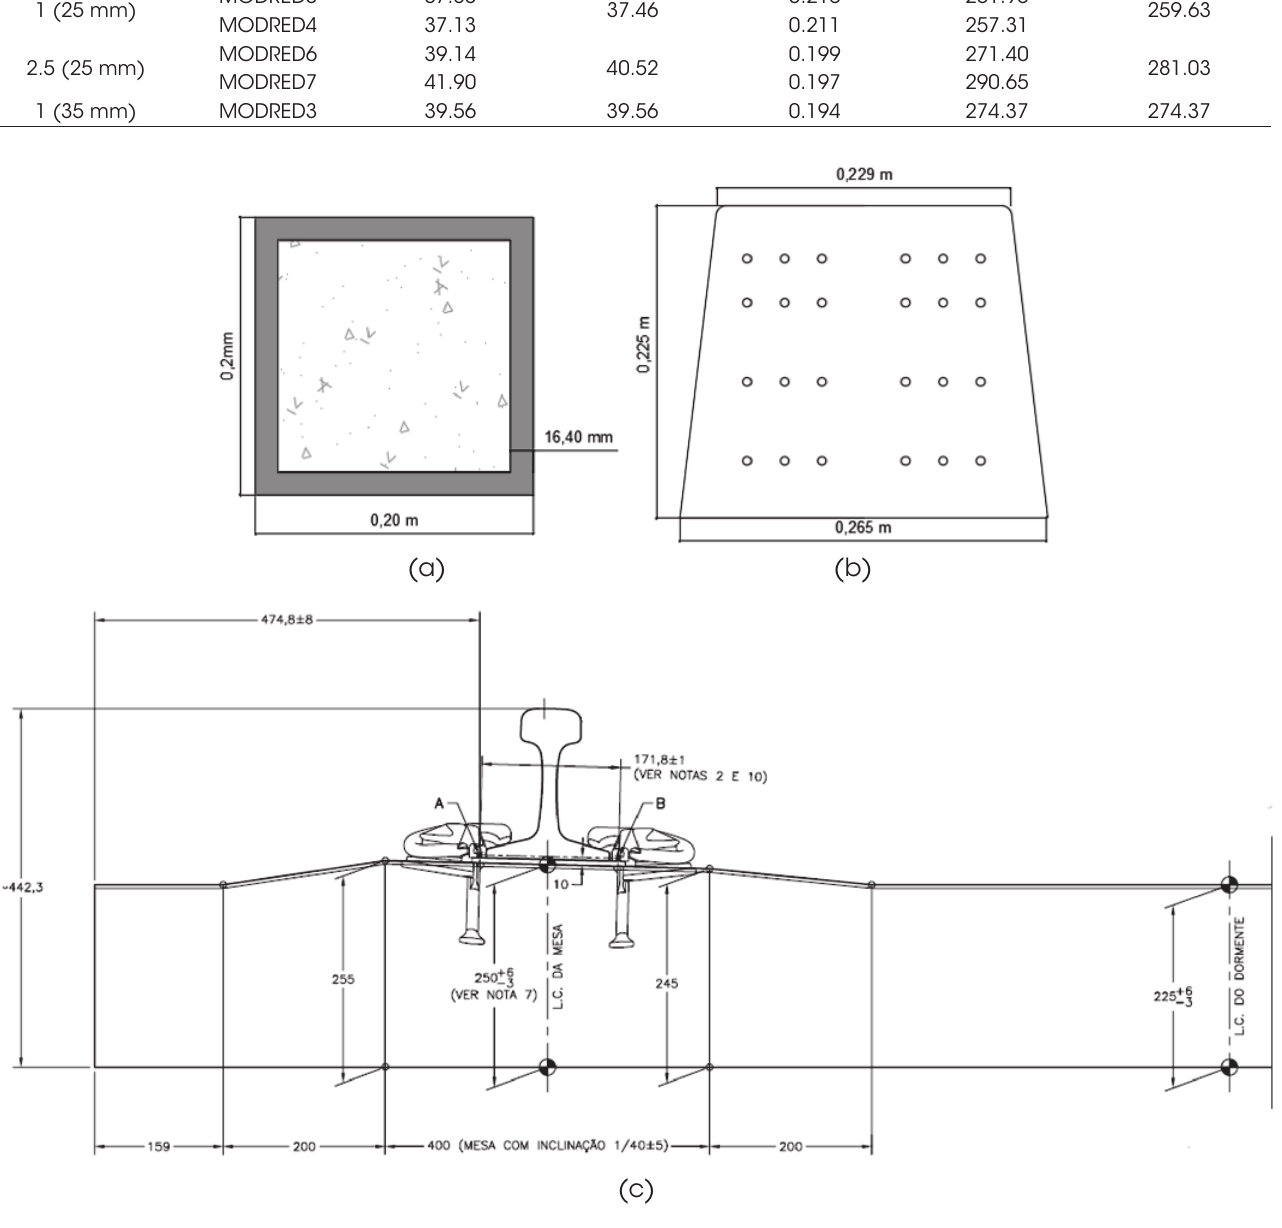
Transversal section in the center of the sleeper: (a) hybrid and (b) prestressed concrete and (c) half-view of the prestressed concrete sleeper DORBRÁS [19]